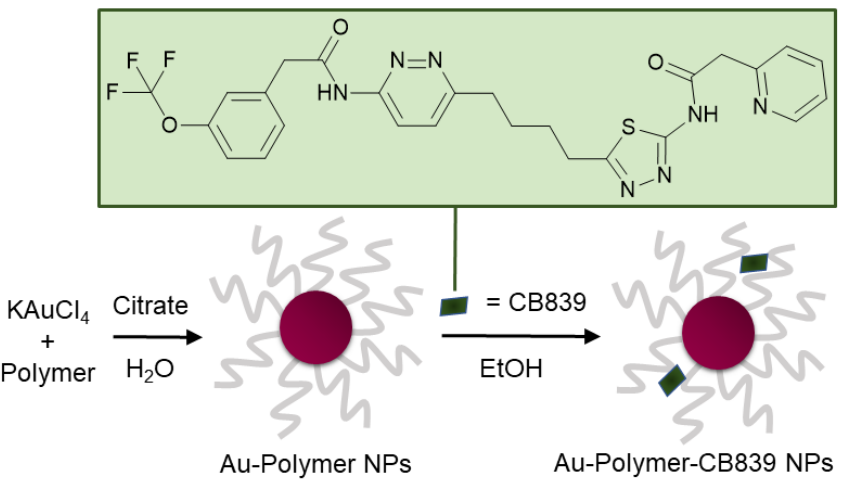
Figure 1. Schematic synthesis of polymer coated gold nanoparticles (Au NPs) carrying the CB839